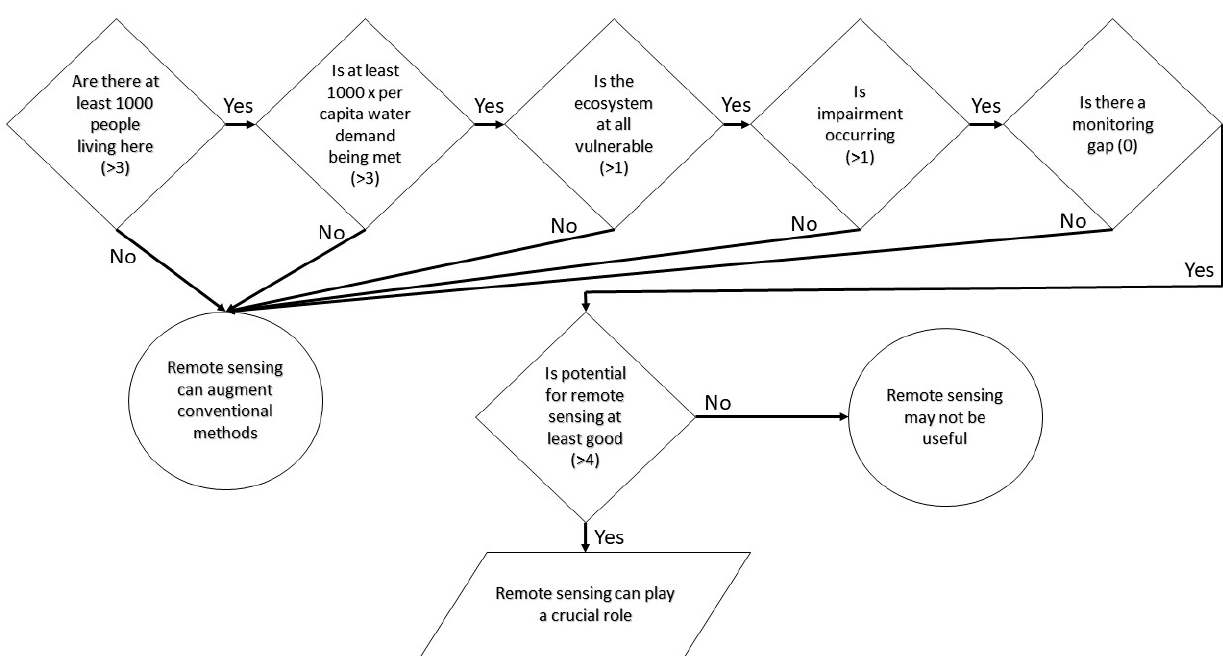
Figure 3. Flowchart for estimating where the role of remote sensing will be crucial in watershed management. The operation represents the intersection of geospatial layers. The numbers indicate threshold values of various index levels.